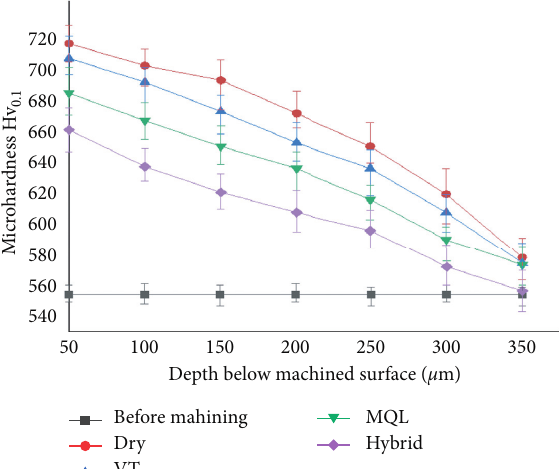
Figure 8: Effect of machining environment on the microhardness of machined surface of AISI 52100 steel at cutting speed, 200 m/min and feed, 0.2